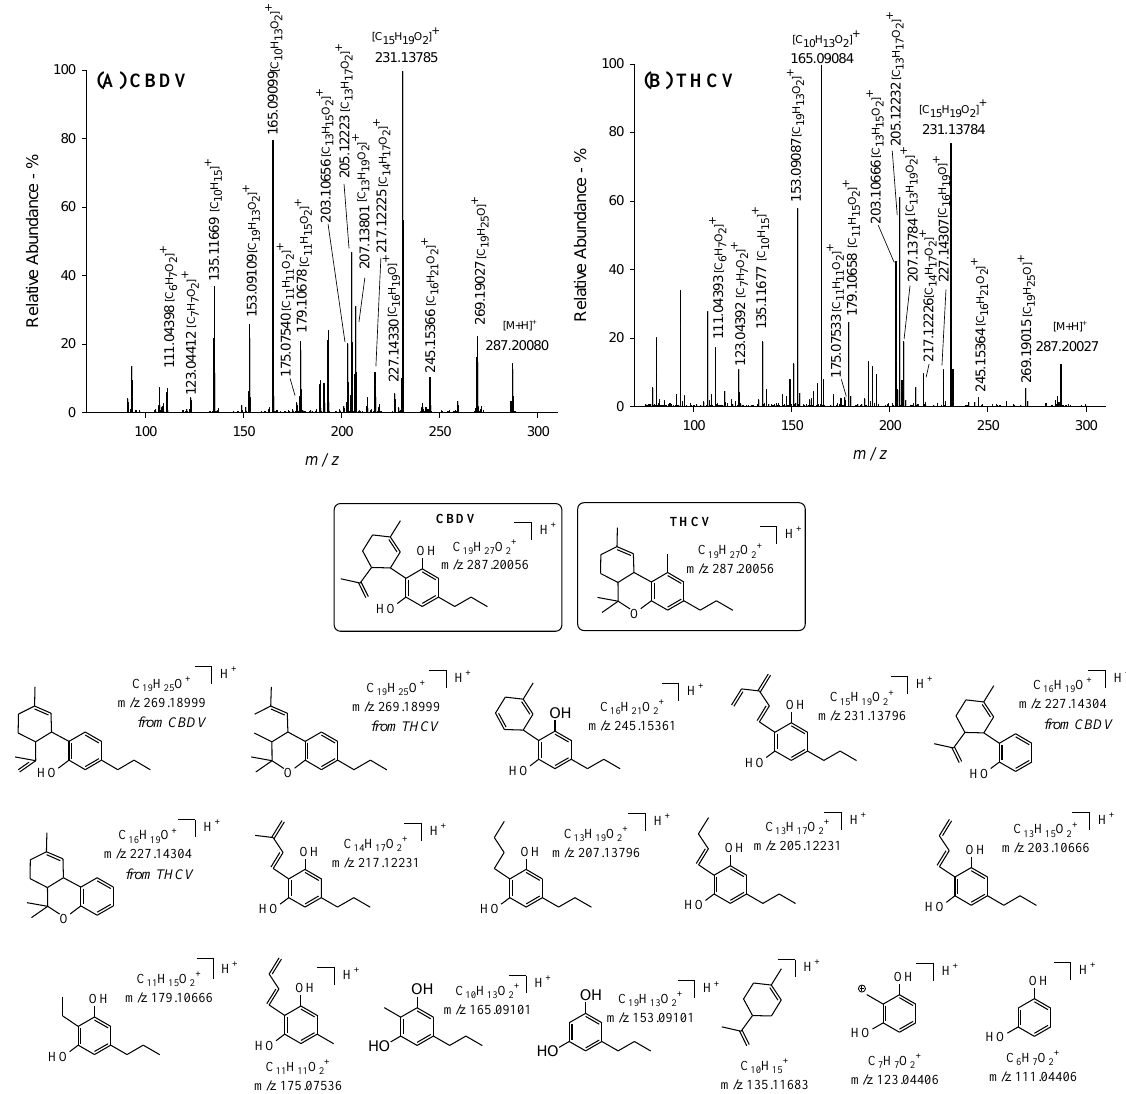
Figure 6. ( A ) FTICR IRMPD MS spectrum of the protonated cannabinoid CBDV at m / z 287 (peak one in the chromatograms of Figure 1); the [M+H] + precursor ion was photon-irradiated for 290 ms at 100% laser power and ( B ) FTICR IRMPD MS spectrum of the protonated cannabinoid THCV at m / z 287 (peak two in the chromatograms of Figure 1); the [M+H]+ precursor ion was photon-irradiated for 290 ms at 100% laser power. The structures of product ions for CBDV and THCV, based on IRMPD-MS/MS data, are reported on the bottom side of the mass tandem spectra: the m / z values of all fragments are shifted of an ethylene portion (CH 2 -CH 3 , 28 amu) moving from CBDV and THCV to CBD and THC, except for fragments of the constant terpenic portion.